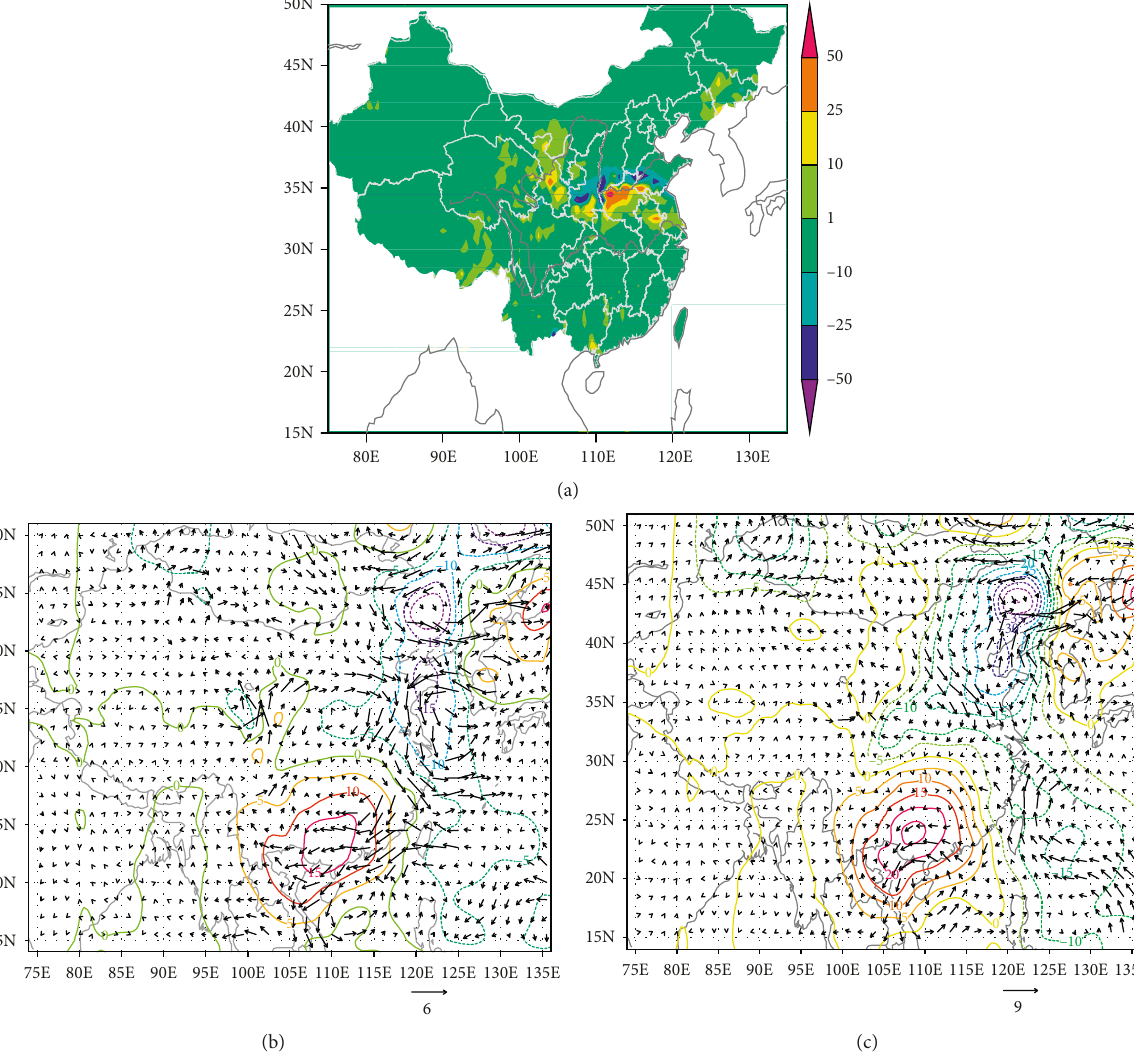
Figure 3: 24-hour cumulative precipitation forecast difference between the quality control plan (REF_QC) and nonquality control plan (REF_NQC) (Figure 3a; unit: mm) and the difference in the initial values of the data assimilation analysis (Figure 3b: 700hPa; Figure 3c: 500hPa). The contour represents geopotential height increments (unit: GPM). The arrow vectors represent wind speed increments in